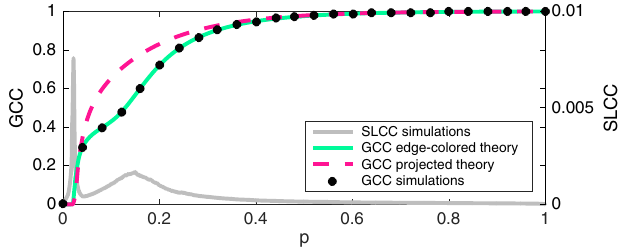
FIG. 3. Expected size of the GCC as a function of p for a three- layer multiplex network made of three Poisson random networks. Each layer contains N ¼ 10 4 nodes. Layers 1 and 2 have an overlap of 10 3 nodes, as do layers 2 and 3. Peaks in the expected size of the SLCC indicate percolation transitions.